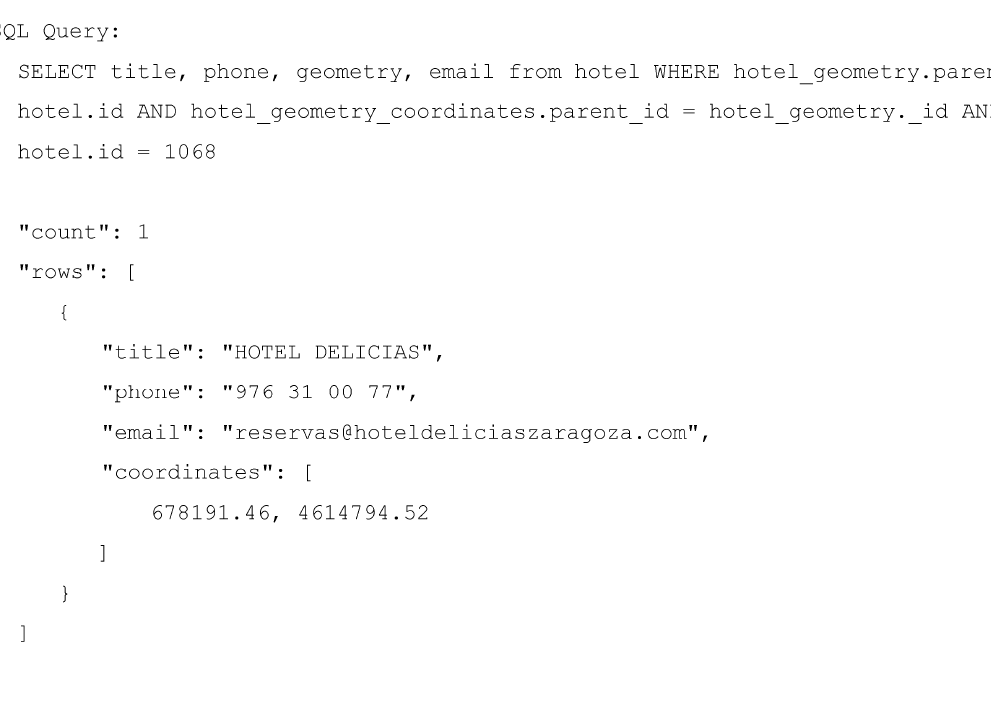
Figure 8. Data serialized in JSON format obtained from the execution of the SQL select statement.